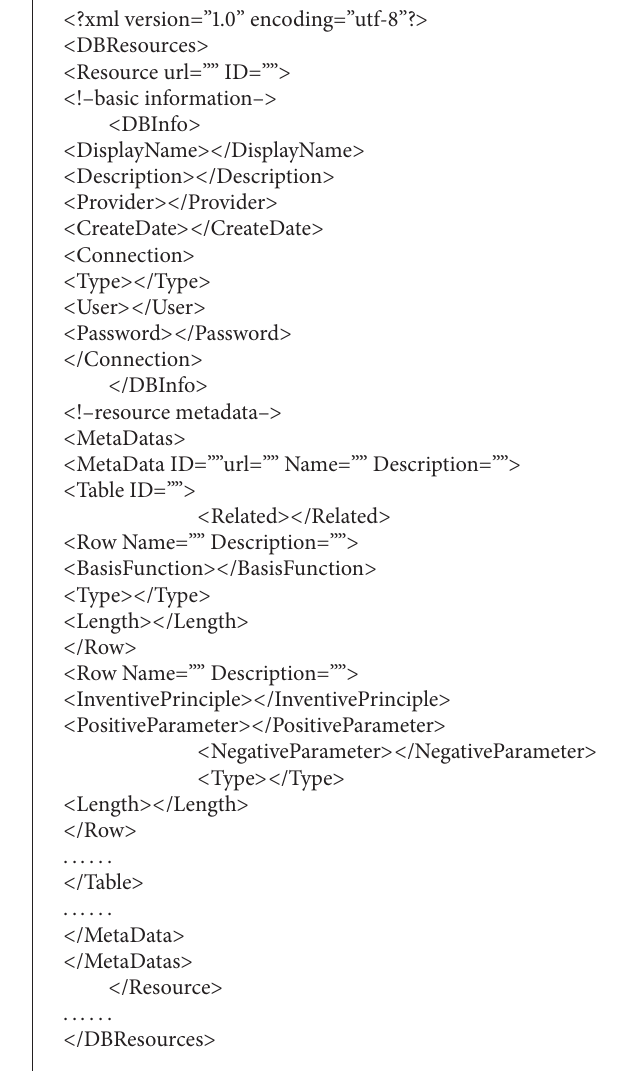
Table 1: Basic information of database resources.